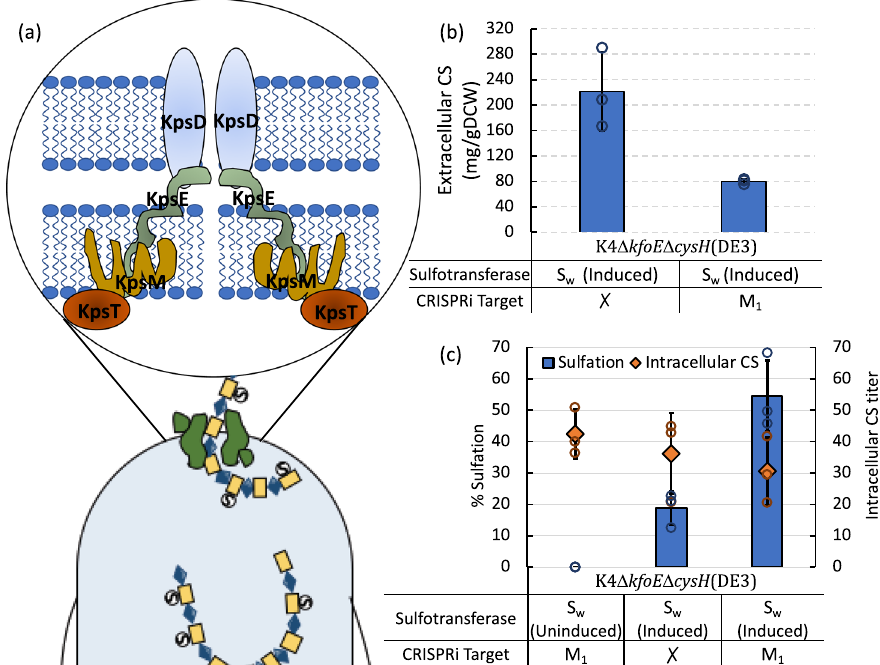
Fig. 5 Effect of export on CS sulfation. a Representation of currently accepted CPS transport complex in E. coli producing group 2 capsules. b Repression of GAG transport using CRISPRi in K4 Δ kfoE Δ cysH (DE3)pETM6-S w showing 2.5-fold decreased GAG export. c CS sulfation in transport repressed K4 Δ kfoE Δ cysH (DE3) expressing S w with uninduced and unrepressed controls. Error bars represent standard deviation from three biological replicates. Source data underlying Figs. 5b and c are provided as a Source Data fi